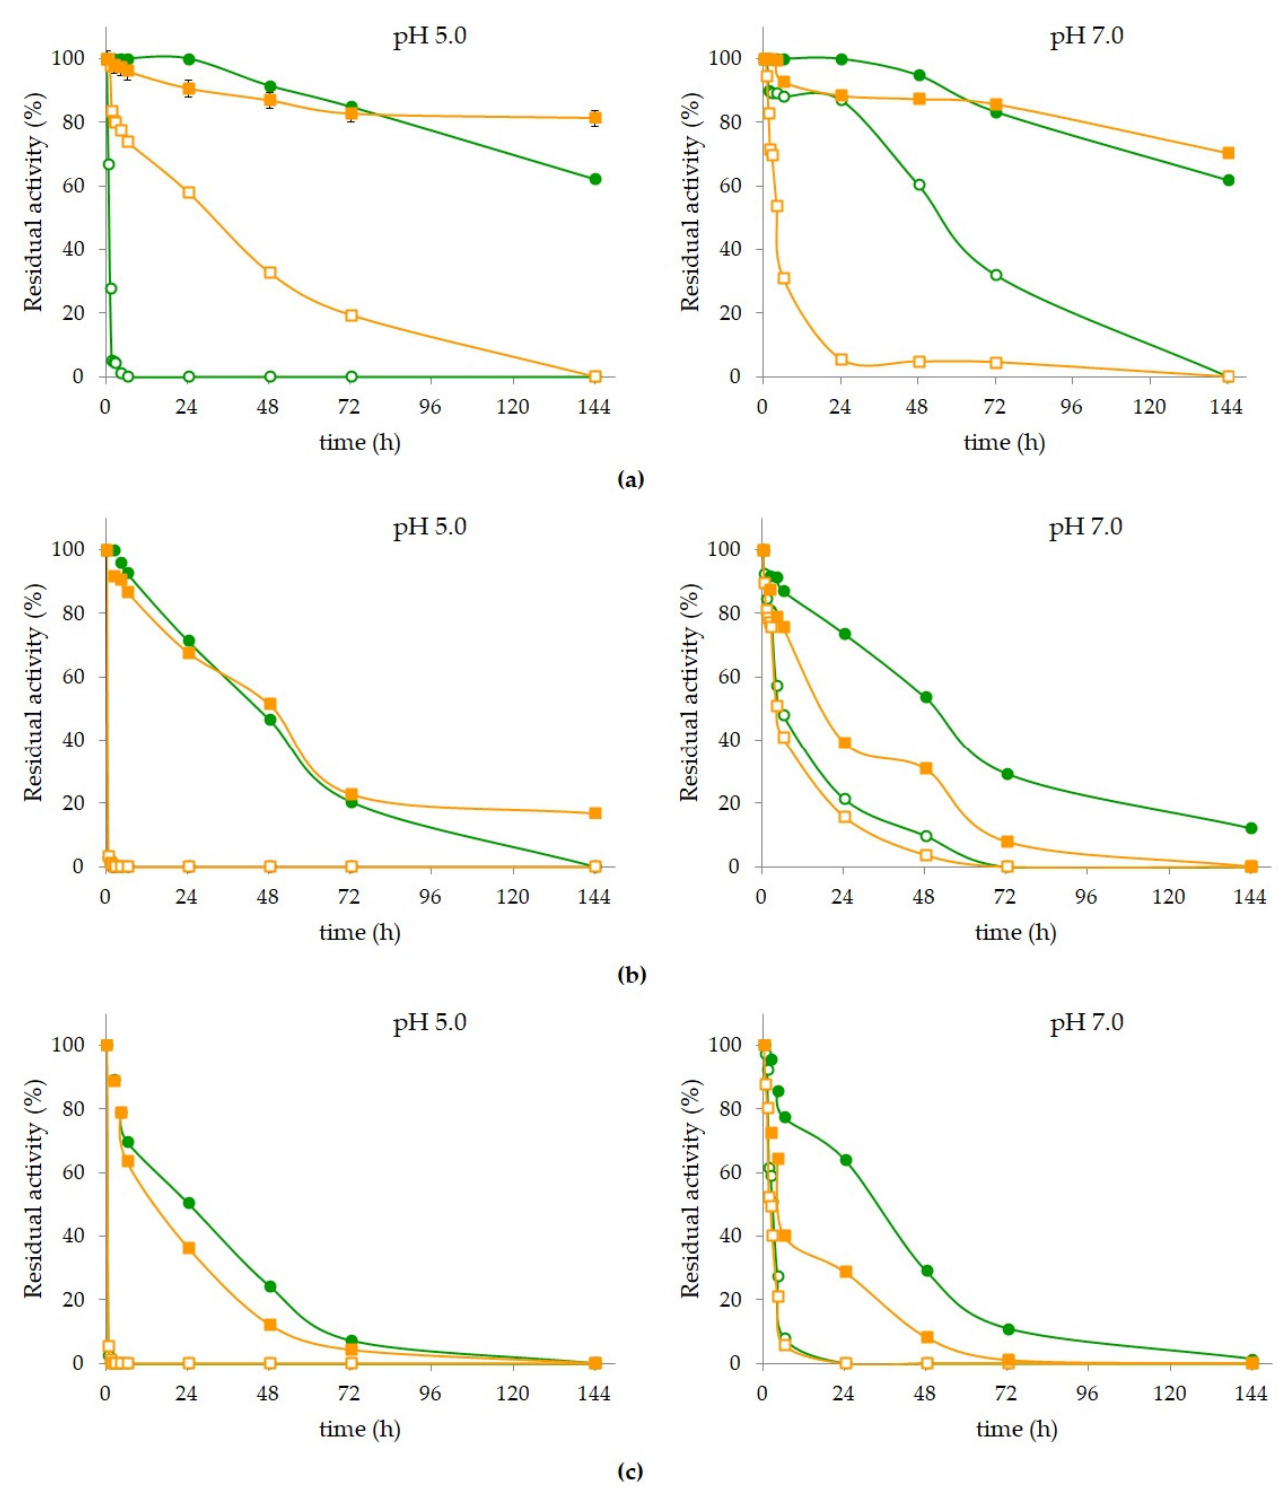
Figure 1. Thermal stability of soluble enzymes: ( ○ ) Endocellulase (E-CELBA) and ( □ ) β -glucosidase (E-BGOSPC); and derivatives ( ● ) E-CELBA/DIOMNP and ( ) E-BGOSP/GLA. Experiments were carried out in 25 mM sodium phosphate pH 5.0 and 7.0, at ( a ) 60 °C, ( b ) 70 °C, and ( c ) 80 °C.